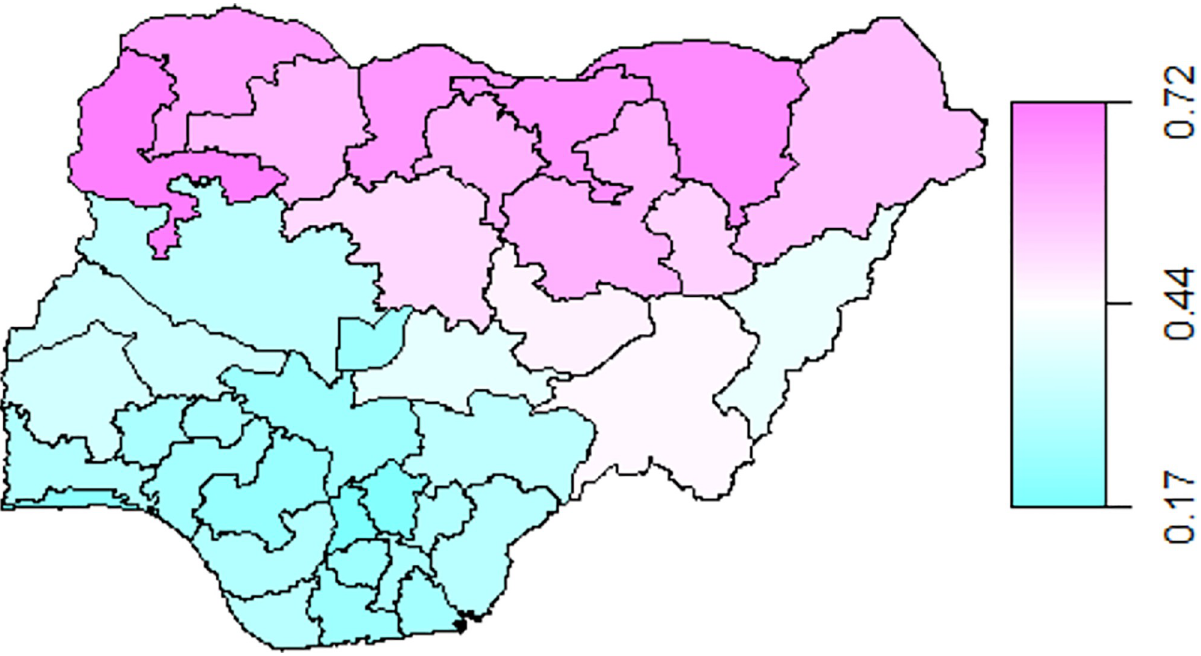
Fig 2. The CIAF prevalence per Nigerian state based on NDHS 2018 data.